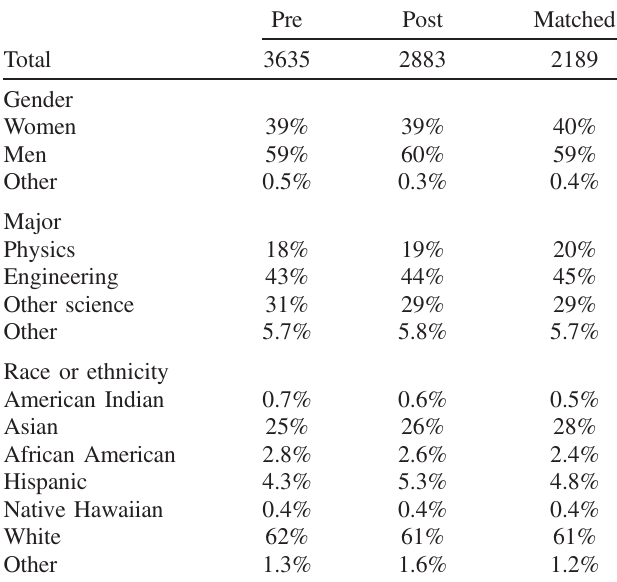
TABLE V. Percentage of respondents in valid pre-, post-, and matched datasets broken down by gender, ethnicity, and major. Students had the option to not disclose this information, so percentages may not sum to 100%.